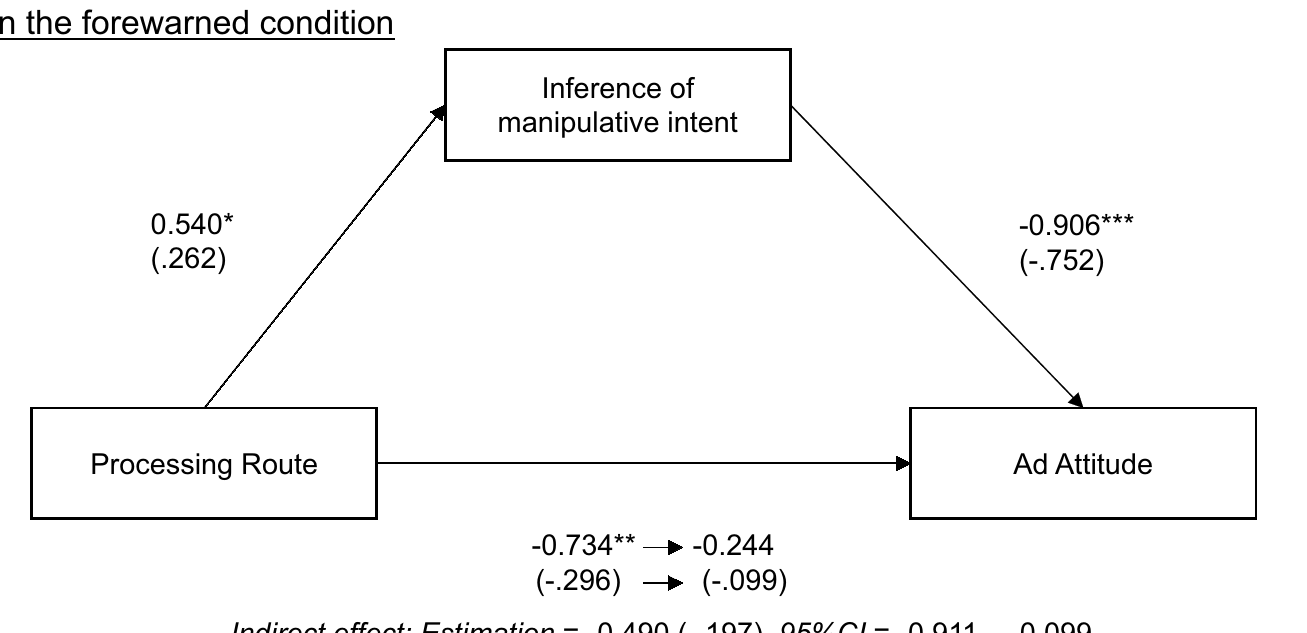
Fig 3. Mediation analysis: Ad attitude mediated by